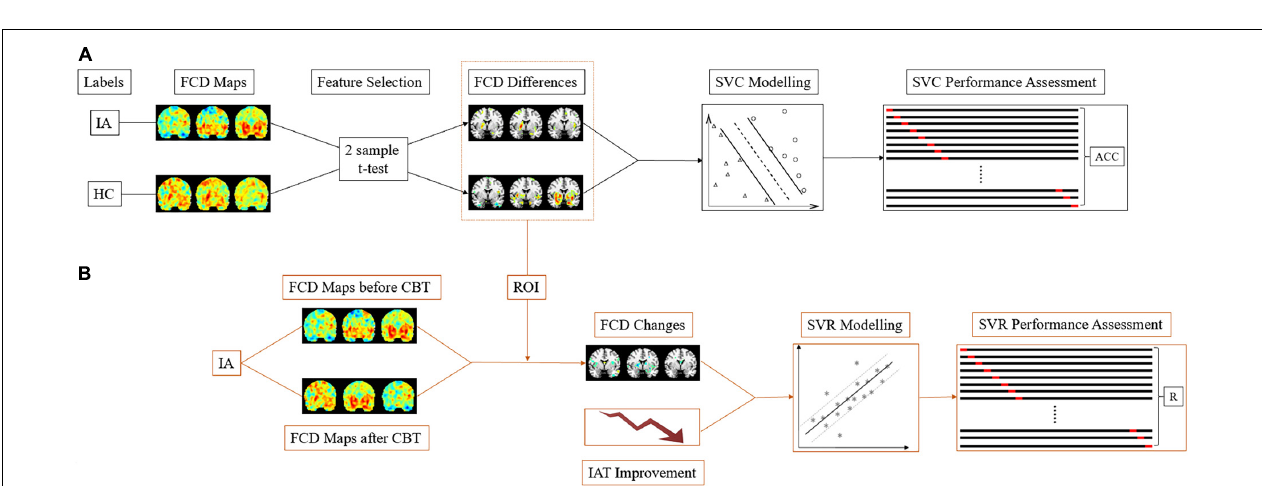
FIGURE 1 | Flow diagram of study procedure. At baseline, fMRI images were acquired from both the HC and IA groups. Based on informative FCDs, the SVC model was applied to the identification of individuals with IA. After 8-week CBT sessions, individuals with IA were rescanned for fMRI data. The change in informative FCDs was used to evaluate symptom improvement by the SVR model. IA, internet addiction; HC, heathy control; SVC, support vector classification; SVR, support vector regression; IAT, Young’s Internet Addiction Test; CBT, cognitive behavior therapy.